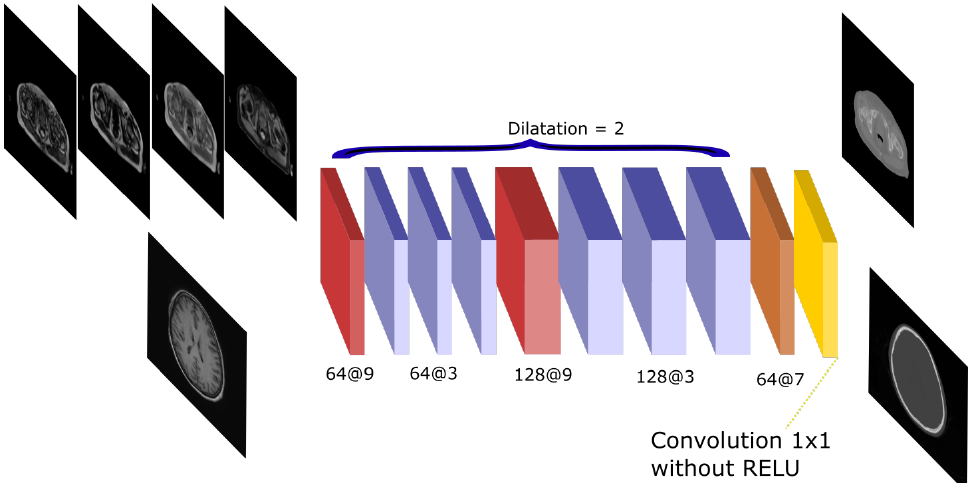
Figure 3. Atrous-Net architecture. The scheme shows the CNN architecture including the atrous convolutions. The network receives either the four Dixon-VIBE MR sequences of the pelvis or the T1-weighted image of the brain as input. Then, it outputs a pelvis or a head pseudo-CT,